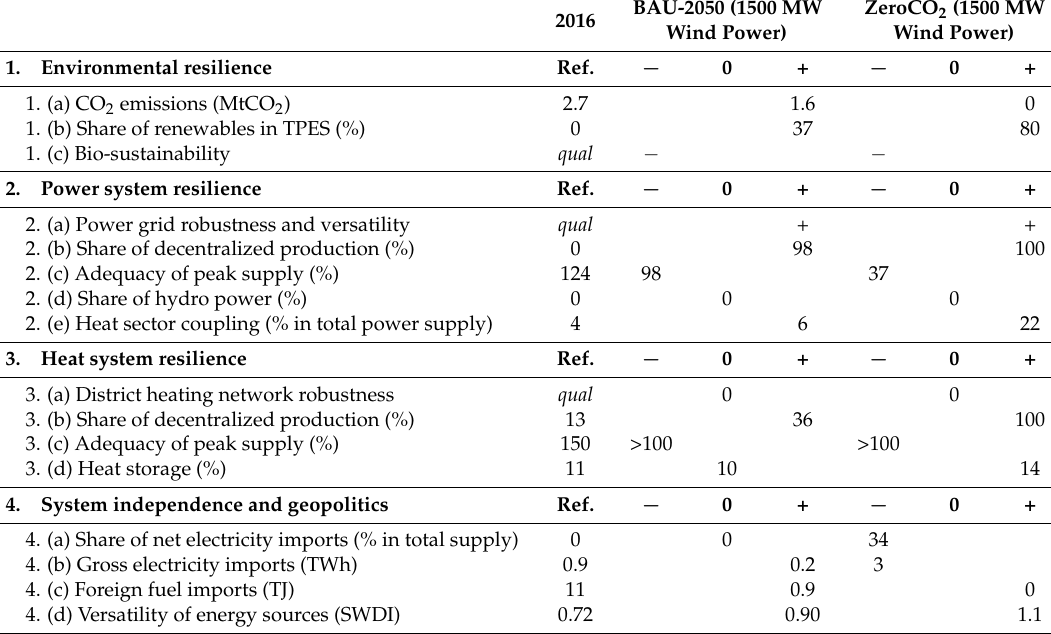
Table 6. Resilience factors and their development in two Helsinki case scenarios. Positive changes with respect to resilience are shown in +-column, negative changes in − -column, and if no significant change occur, the new value is in 0-column. Factors marked with ‘ qual ’ in the Ref. column are analyzed qualitatively ( − = reduced resilience, 0 = neutral, + = increased resilience). Ref. means